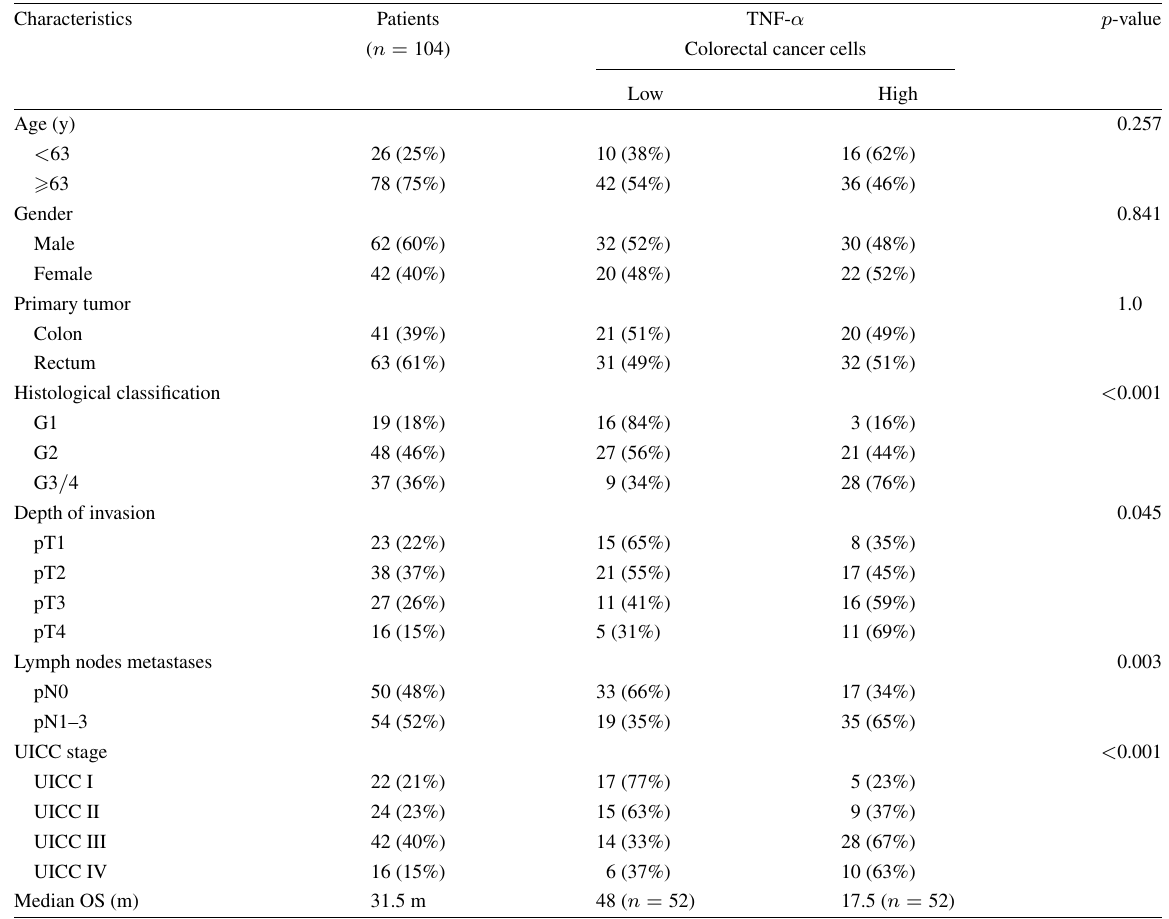
Clinicopathological characteristics of the study